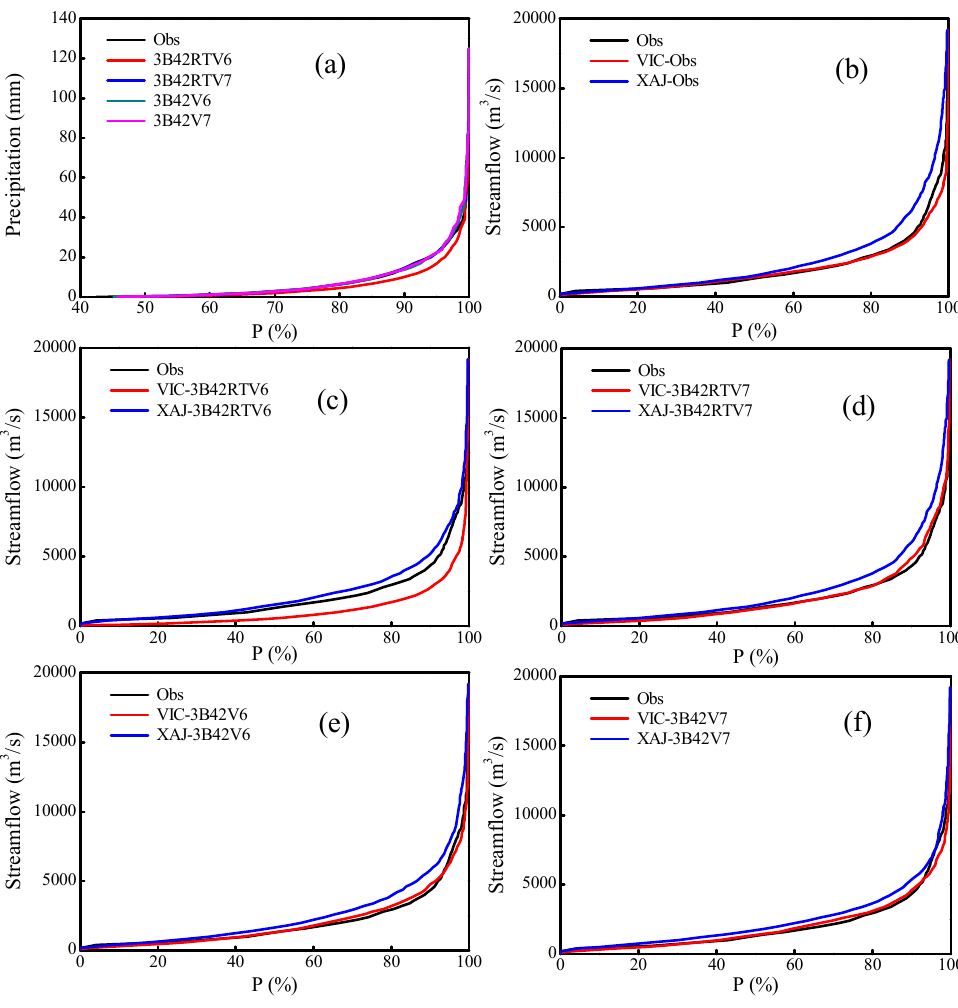
Figure 10. Cumulative probabilities of the observed streamflow and simulated streamflow using the XAJ and VIC hydrological models in the Ganjiang River basin (the difference in the observed and simulated probability distributions was statistically significant at the 0.05 significance level with Kolmogorov-Smirnov statistic).